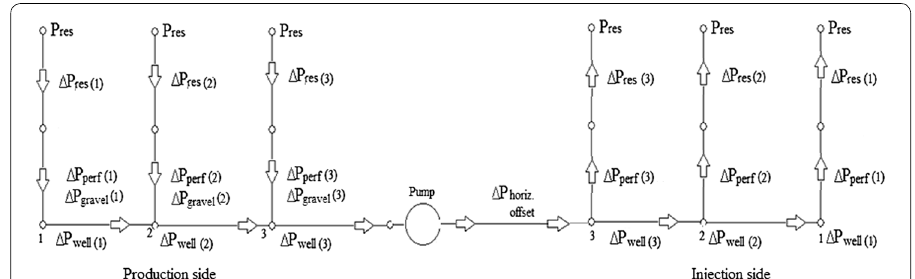
Fig. 5 Pressure distribution scheme along a horizontal well. Three influx and outflux paths are shown for